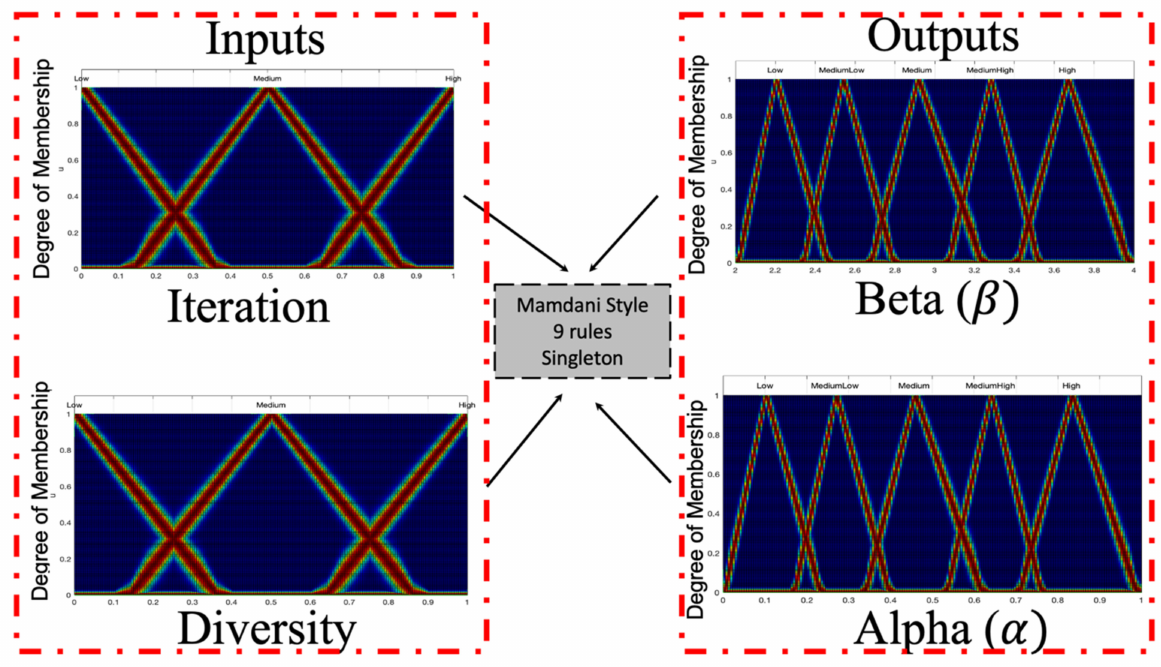
Figure 20. Fuzzy Proposal BCO using a IT3FLS.